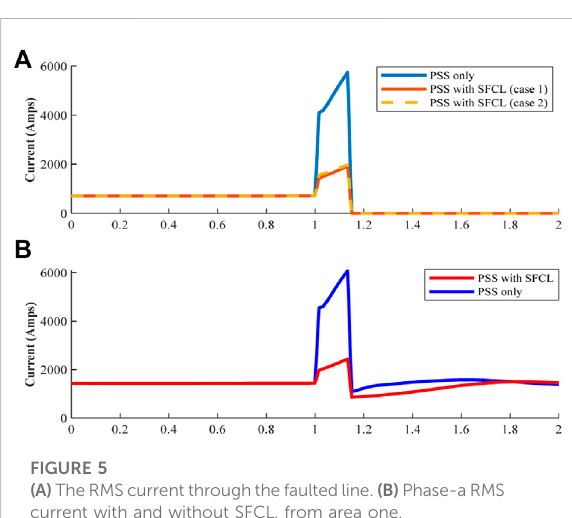
FIGURE 5 (A) TheRMScurrentthroughthefaultedline. (B) Phase-aRMS current with and without SFCL, from area